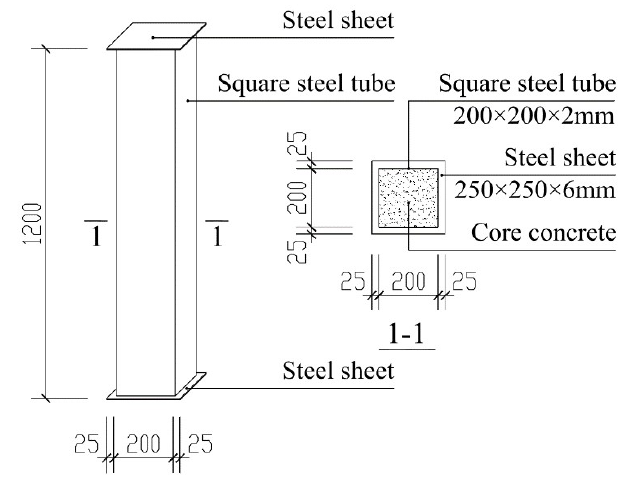
Figure 2. Details of column specimen.